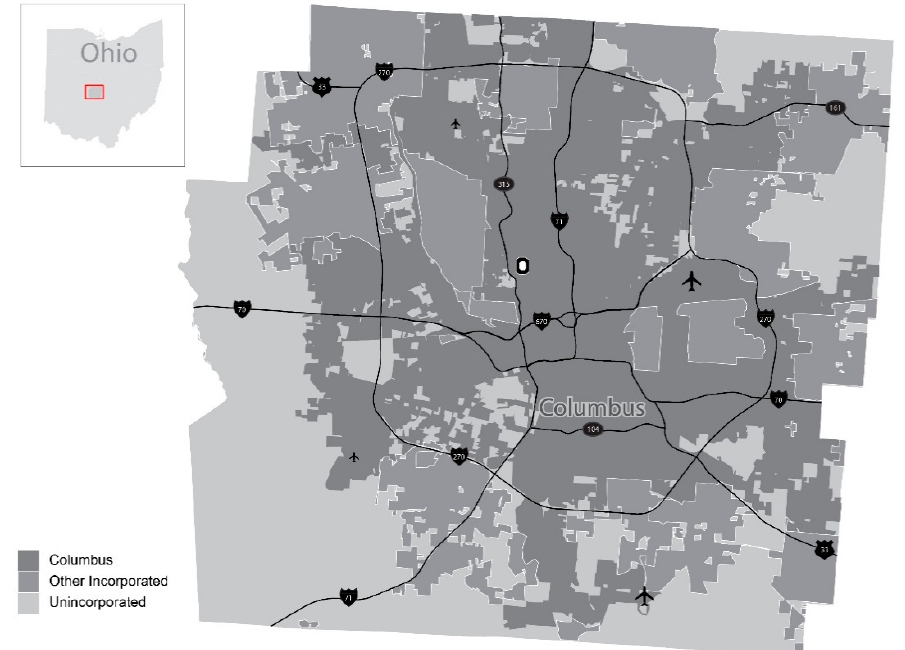
Figure 1. Study area, Franklin County, Ohio.